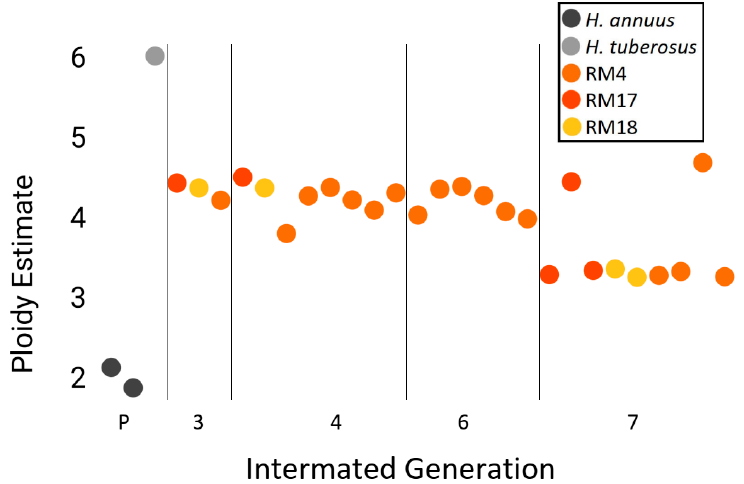
Figure 5. Genome size changes over intermating generations. “P” = parent species. Colors indicate maternal line.